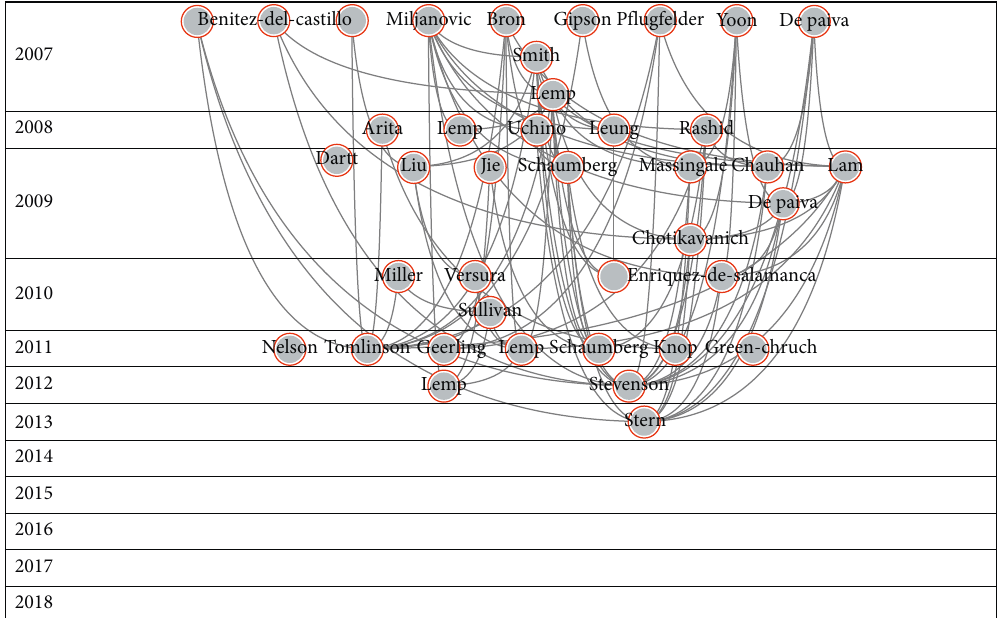
Figure 8: Core Publication of the dry eye citation network